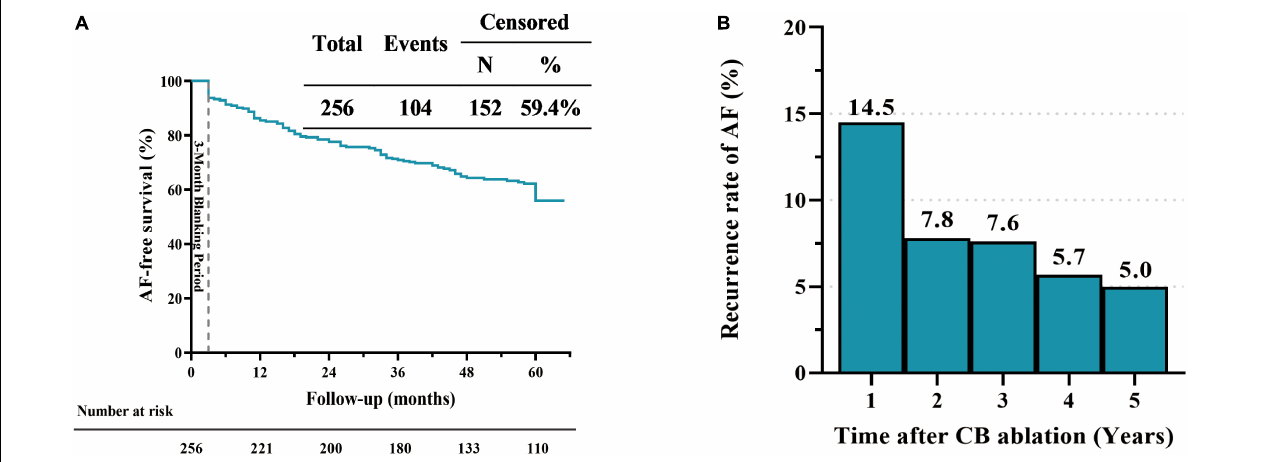
FIGURE 1 | Five-year outcomes in patients with atrial fibrillation (AF). Kaplan–Meier curves showing AF-free survival curve after single ablation procedure performed using cryoballoon (A) . The histogram shows the initial recurrences rate of atrial fibrillation at one-year interval during the five-year follow-up after a single cryoballoon ablation procedure (B) .